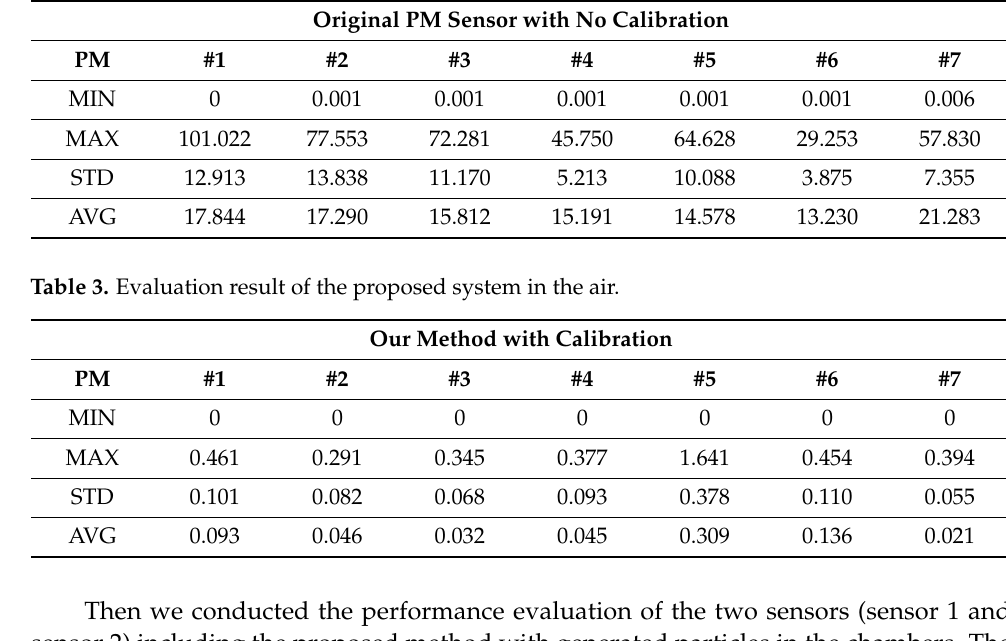
Table 2. Evaluation result of the low-cost sensor in the air.